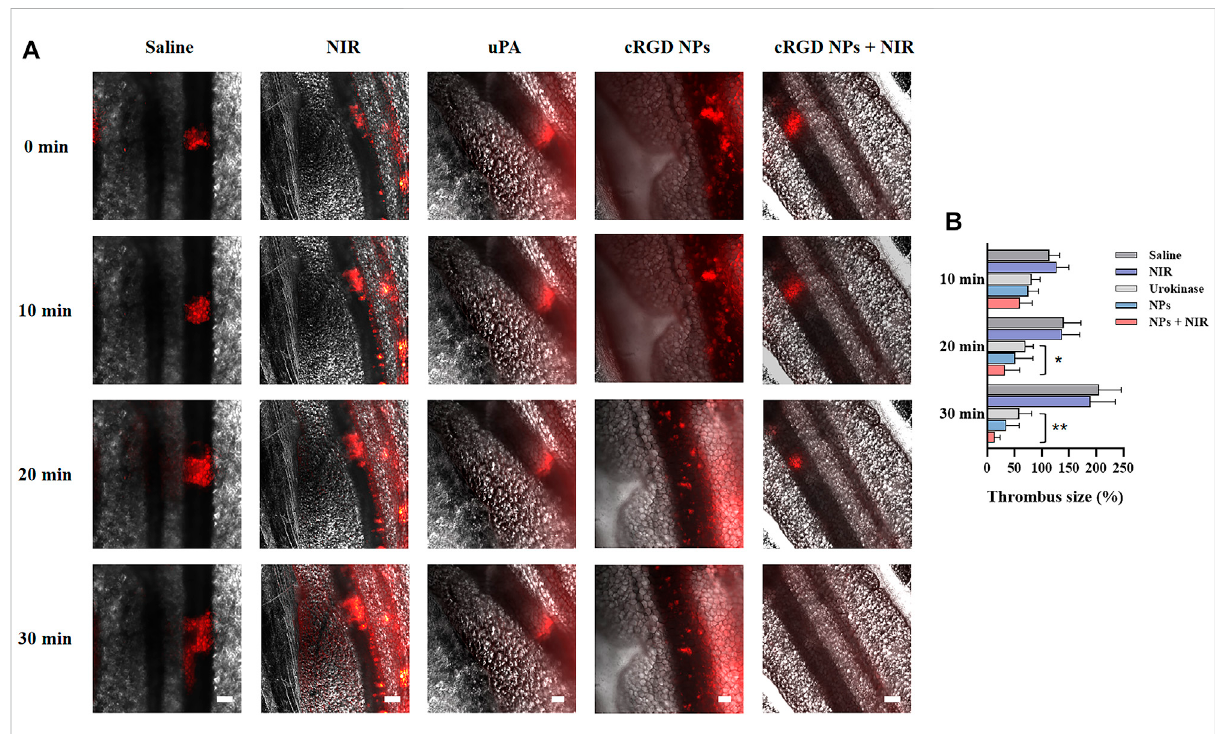
FIGURE 8 (A) Representative fl uorescence images of mice mesenteric thrombus treated with saline, NIR laser irradiation (0.3 W/cm 2 ), free uPA (300 U/g), cRGD-ICG-uPA NPs (100 U/g), and cRGD-ICG-uPA NPs combined with NIR irradiation (100 U/g; 0.3 W/cm 2 ). The imageswere taken at time points of 0, 10, 20 and 30 min post the formation of thrombus (scale bar: 100 μ m). (B) The thrombus size variation in corresponding groups of in vivo thrombolysis study ( n = 5). Data were represented as mean ± SD * p < 0.05, ** p < 0.01.